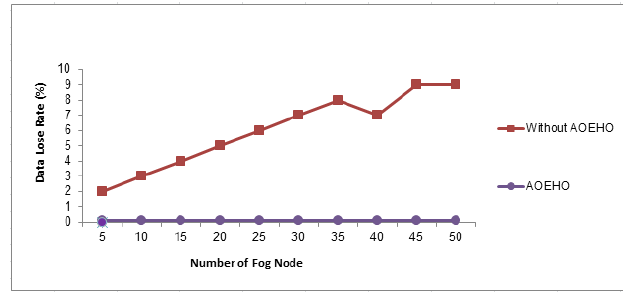
Figure 15. Data lose rate.